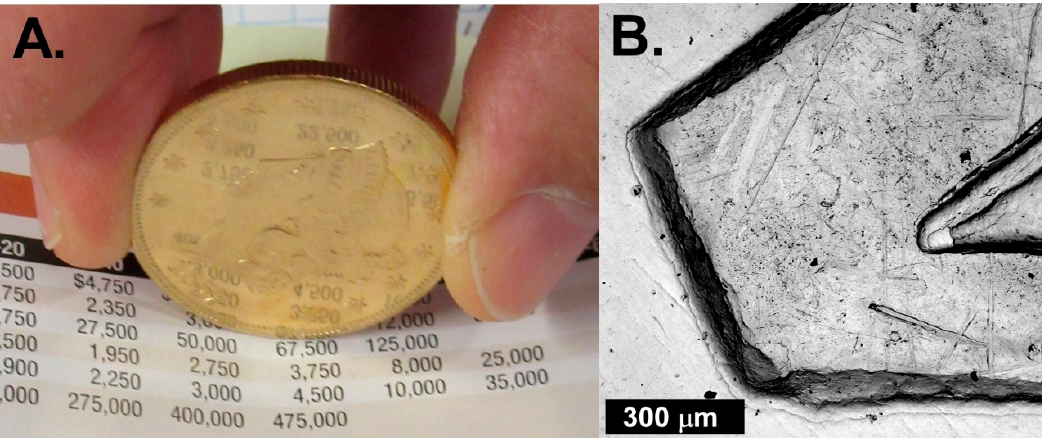
Figure 9. ( A ) The proof-like finish of an 1857-S US $20 gold coin recovered from the shipwreck can still create sharp reflections of text after 157 years on the seafloor. ( B ) SEM imaging of gold coins from the wreck reveal a sharp mint-like state with no evidence of corrosion or pitting.